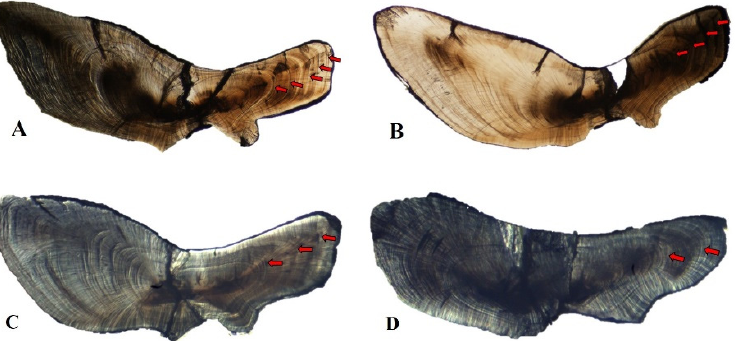
Figure A3. Age determination from otolith of largehead hairtail Trichiurus japonicus . ( A ), 6 years; ( B ), 5 years; ( C ), 4 years; ( D ), 3 years.